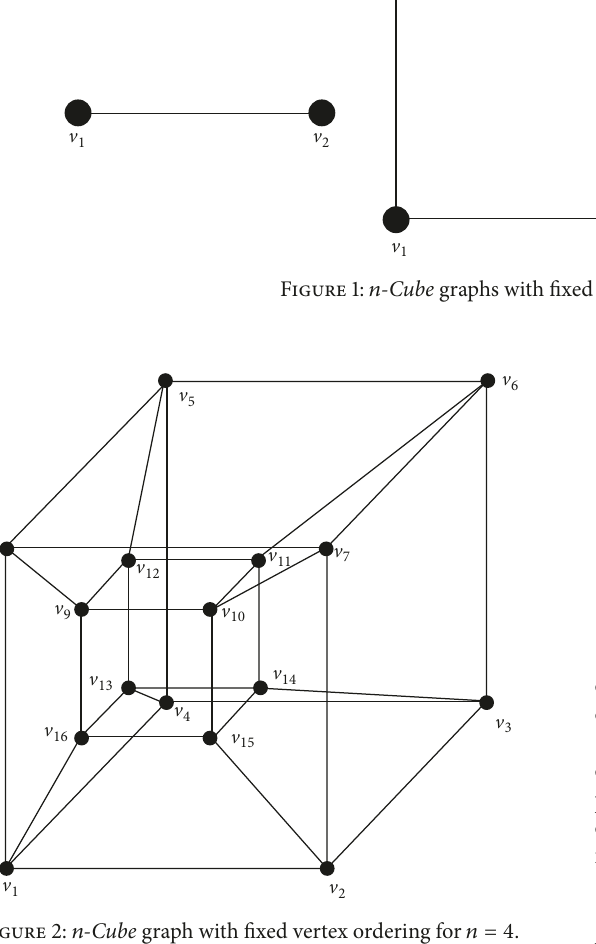
Figure 2: 𝑛 - Cube graph with fixed vertex ordering for 𝑛 = 4 .